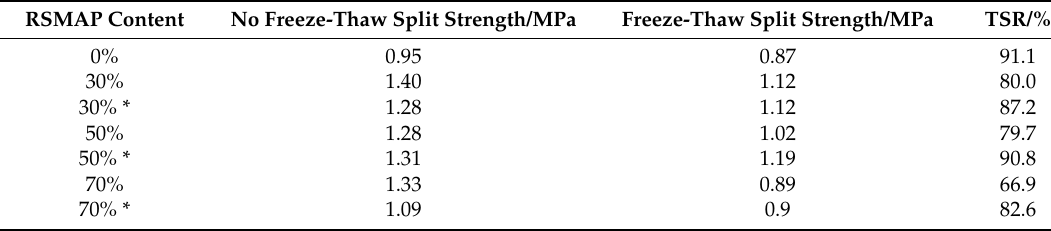
Table 11. Freeze-thaw split test results of recycled